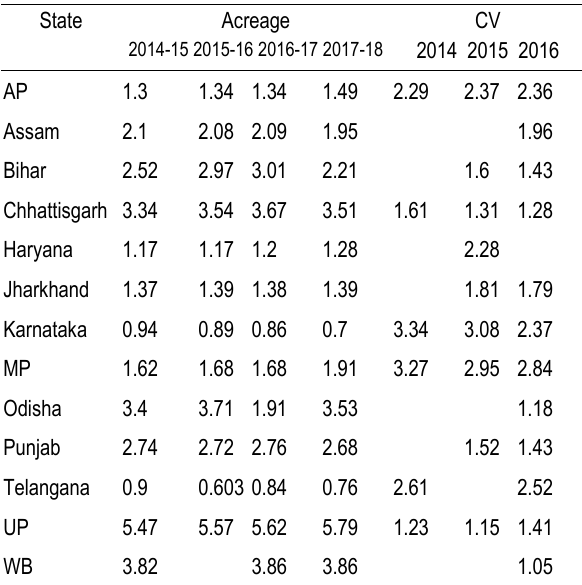
Table 3. Acreage (MHa) versus CV values for different